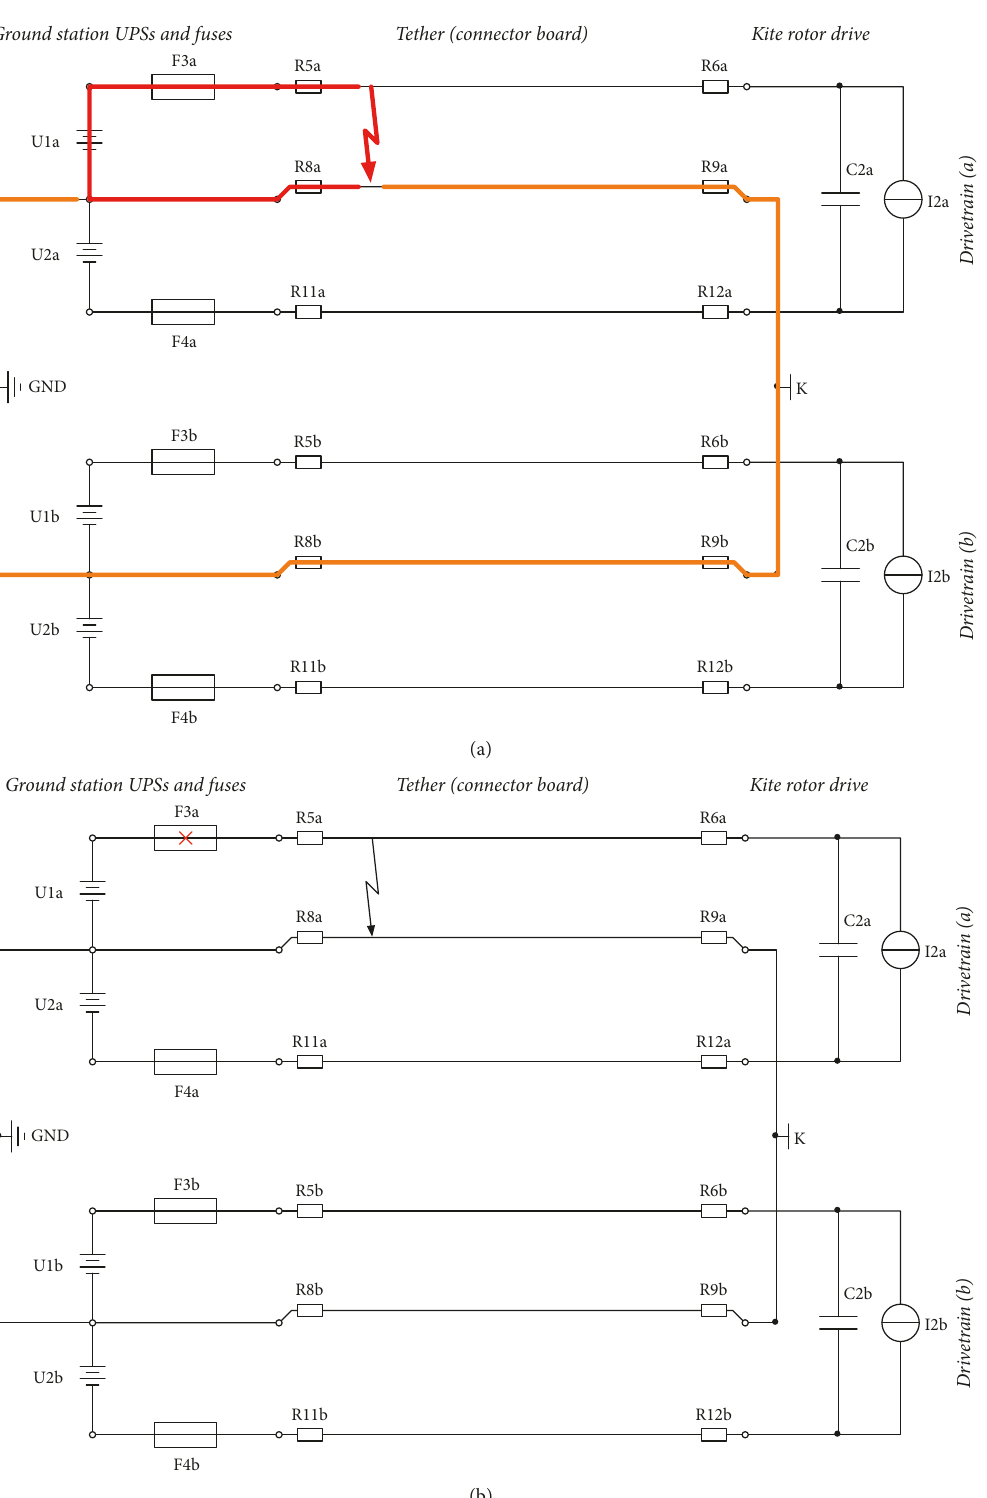
Figure24:InvestigationofshortcircuitfaultS2forthedemonstrator:(a)shortcircuitcurrentsdrivenbyUPS(s)overdifferentpaths(different colors) and (b) circuit after fuse